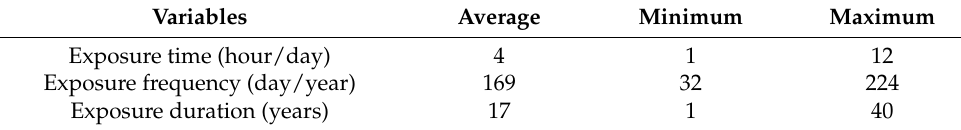
Table 3. Pesticides exposure information of paddy farmers ( n =